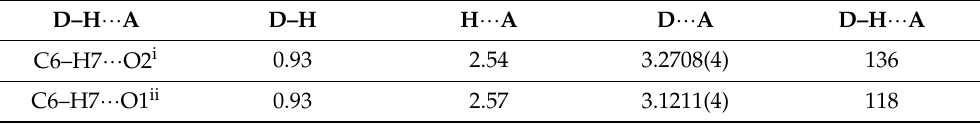
Table 1. Hydrogen bond geometry (Å, ◦ ) for compound 7